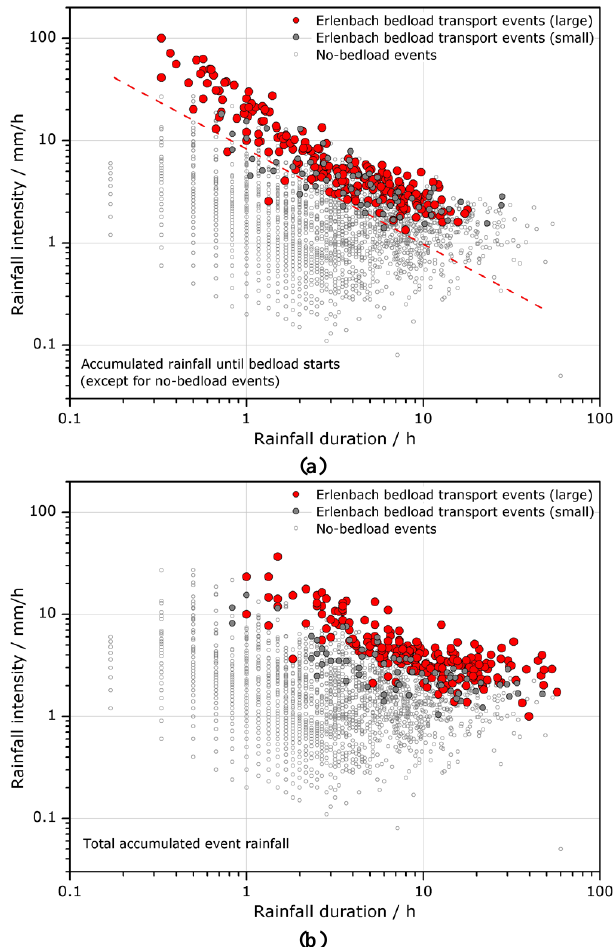
Fig. 2. (a) Intensity–duration relationship I BLS – D BLS for rainfall (recorded until beginning of bedload) that triggered large (red dots) and small (grey dots) amounts of bedload transport in the Erlen- bach catchment. The threshold line is manually fitted and applies to the large transport events; (b) Intensity–duration relationship I T – D T for rainfall (recorded for the entire event) that triggered large and small amounts of bedload transport in the Erlenbach catchment. Grey circles in (a) and (b) indicate rainfall events that did not lead to bedload transport at